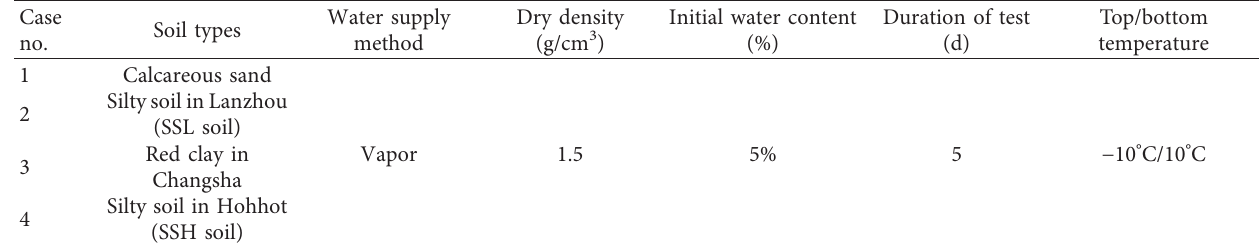
Figure 2: Schematic diagram of the vapor transfer test instrument [12]. Table 1: Influence of different soil types.